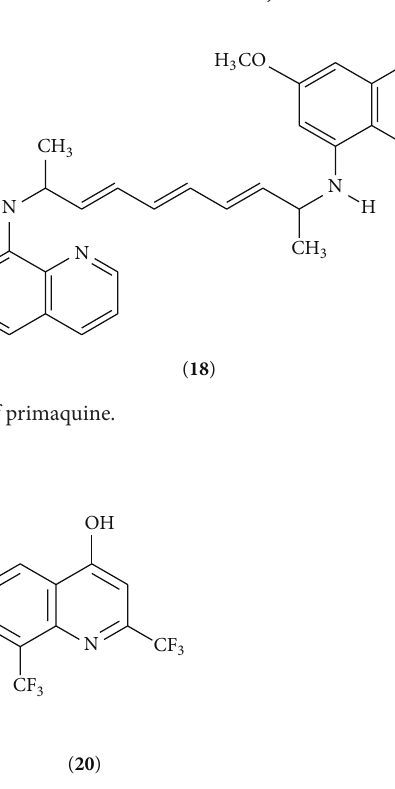
Figure 7: Photoelimination reaction of